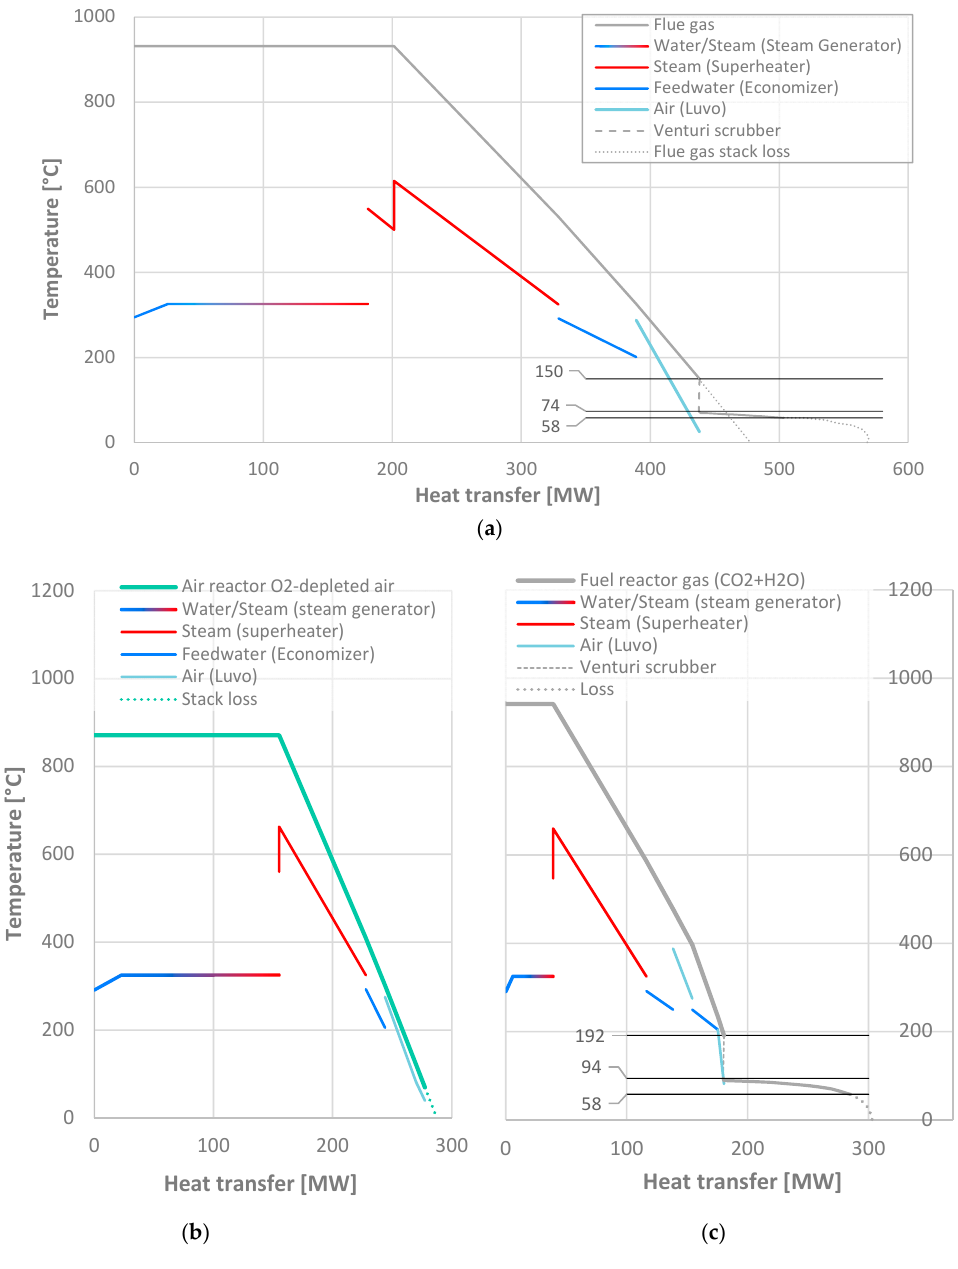
Figure 6. Temperature diagrams for: ( a ) reference plant; ( b ) CLOU air reactor; and ( c ) CLOU fuel reactor. The reference plant with or without flue gas condensation has identical back pass heat transfer surfaces; stack loss is shown both with and without flue gas condensation. The steam generator parts are not intended to be accurate representations of the temperature profiles, but only to depict the heat transfer rate and exit temperatures of gas and steam.